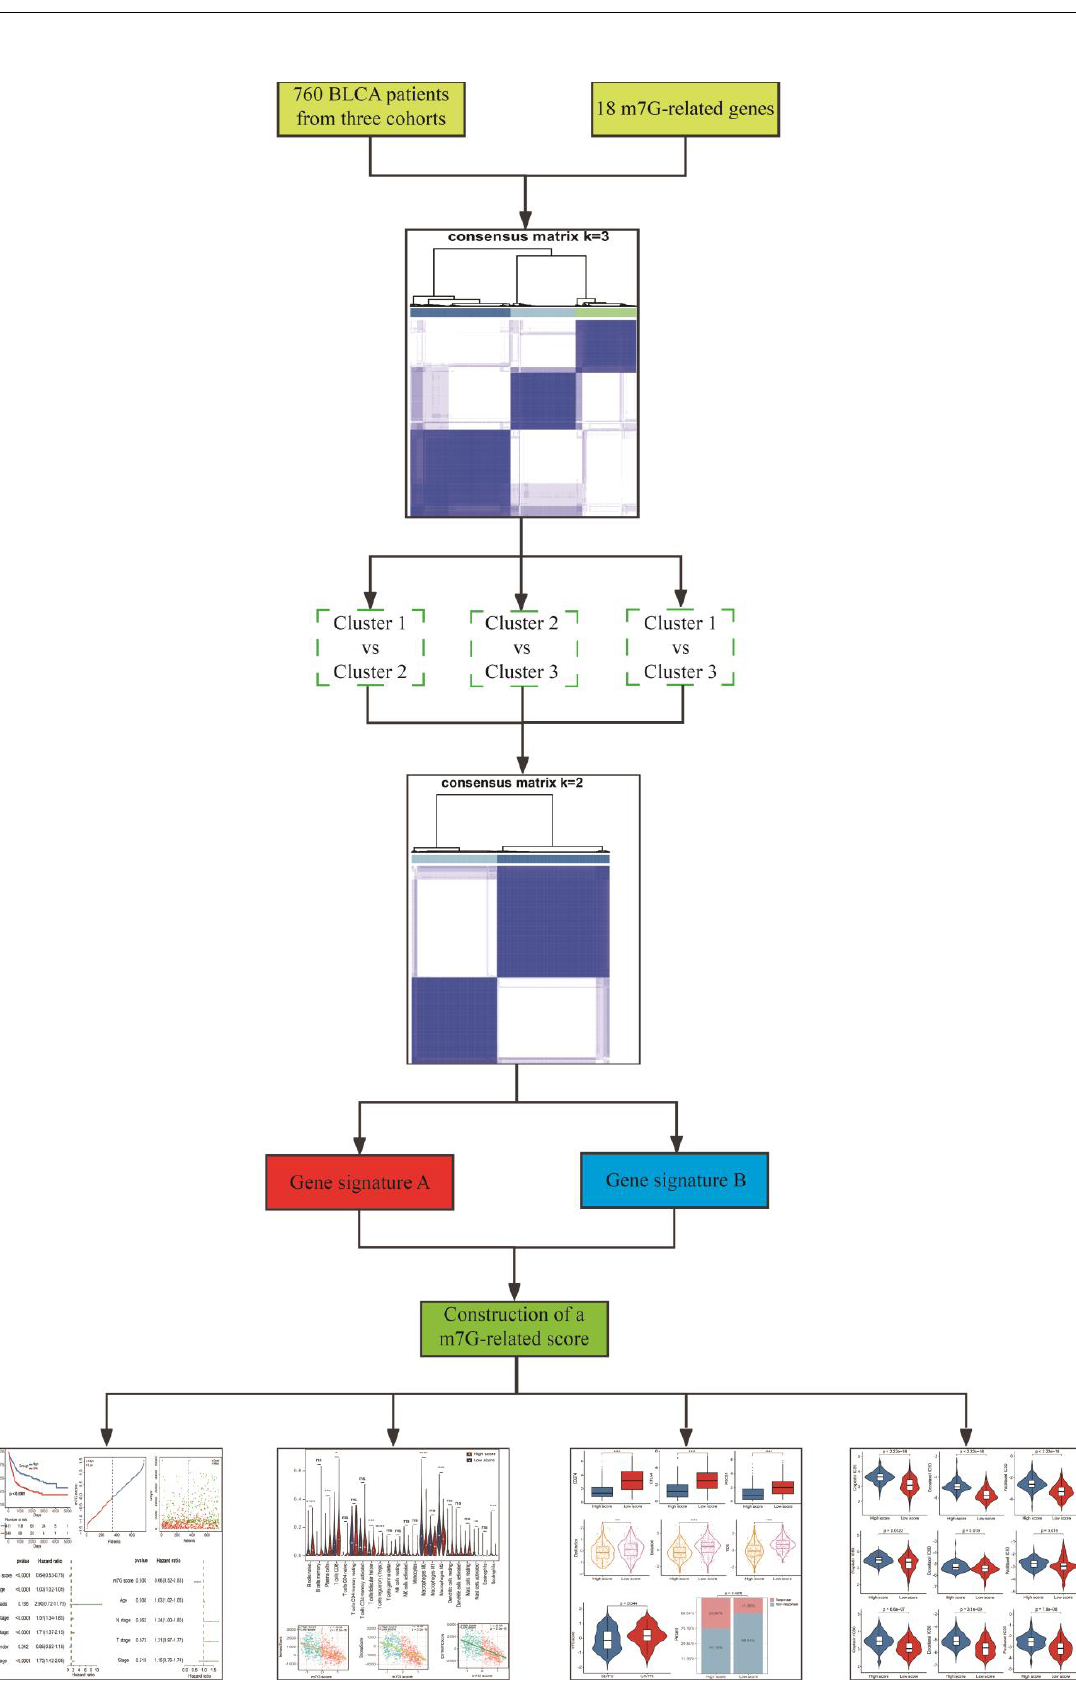
Figure 1. The overview design in this